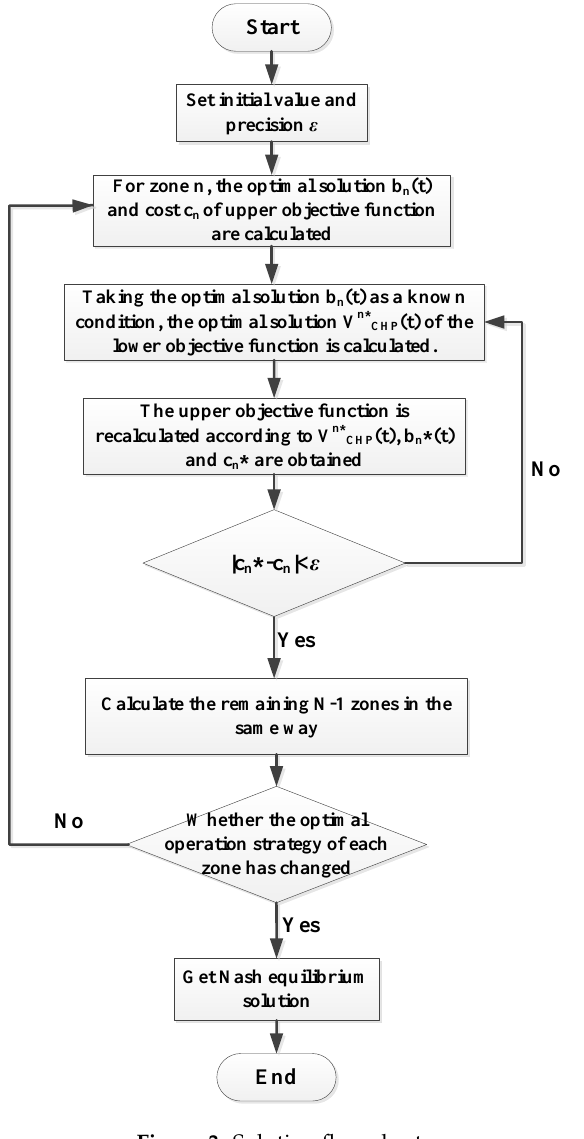
Figure 3. Solution flow chart.